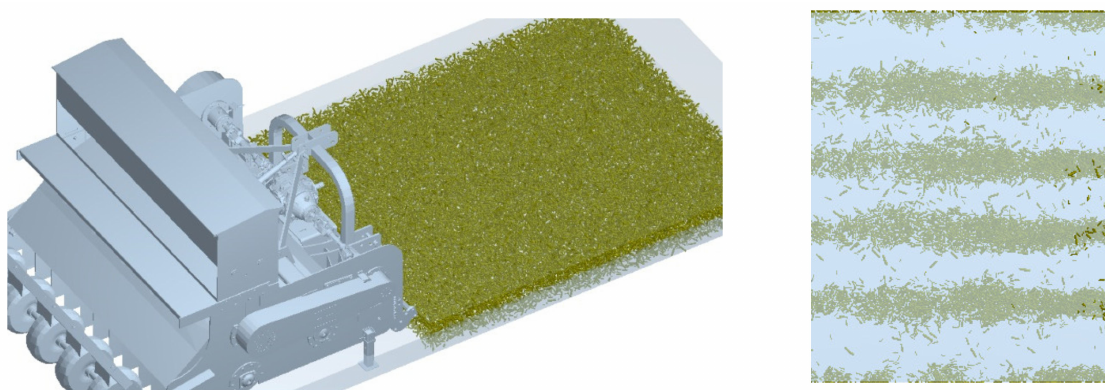
Figure 5. DEM model establishment and numerical simulation.